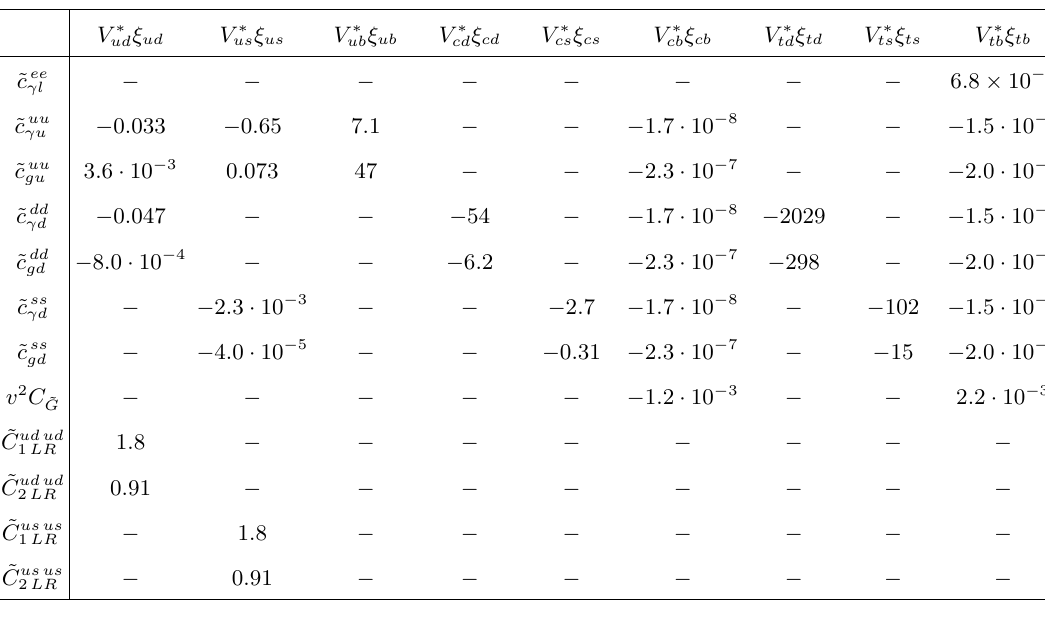
(cid:24) ij ), to the operators at (cid:22) = 2 GeV. ij